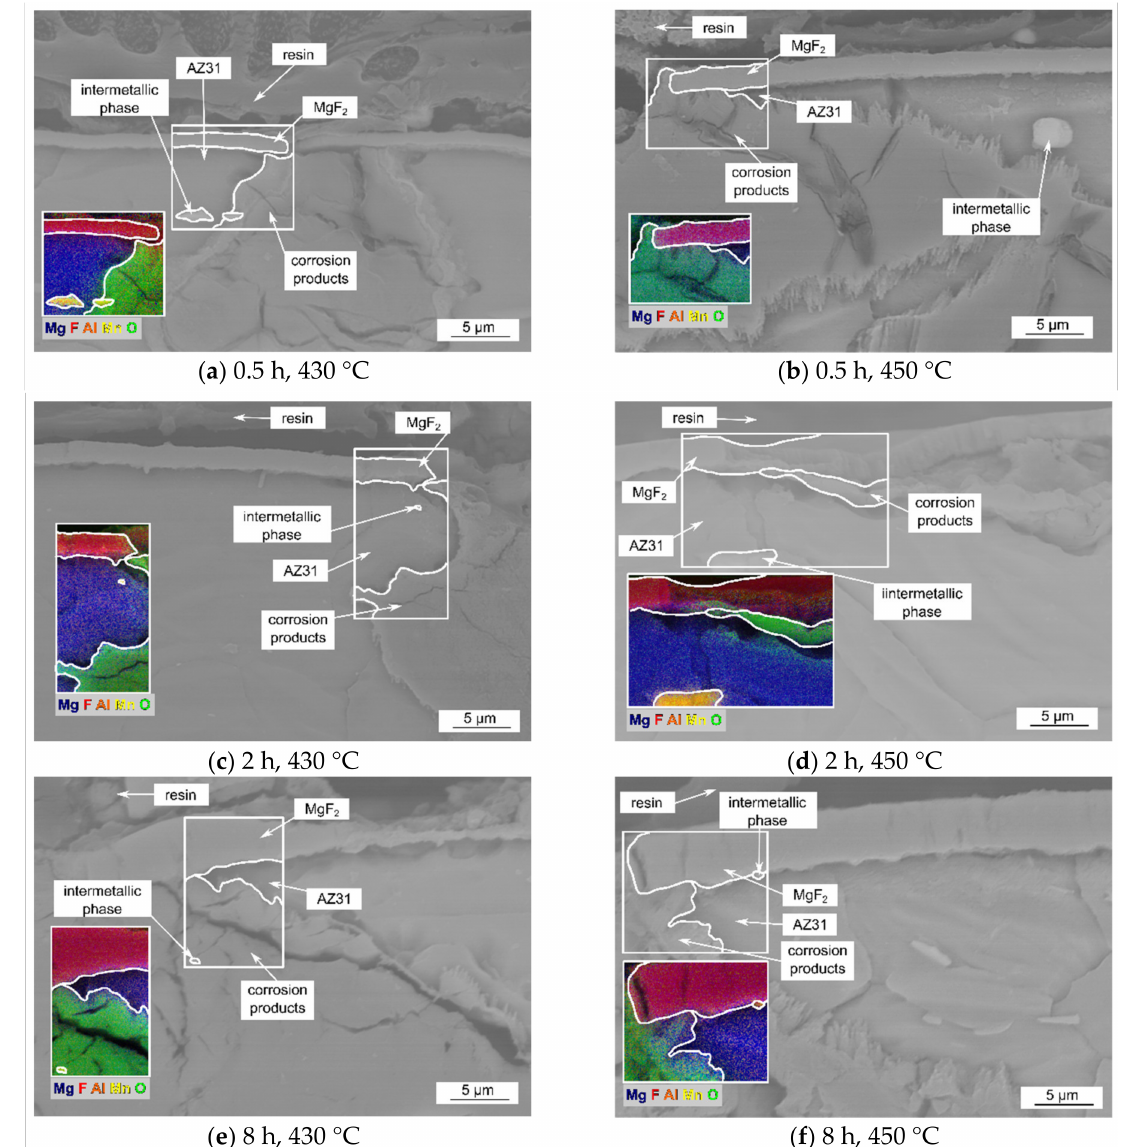
Figure 11. Cross-sections of the coated specimens after immersion in SBF solution for 168 h, SEM,